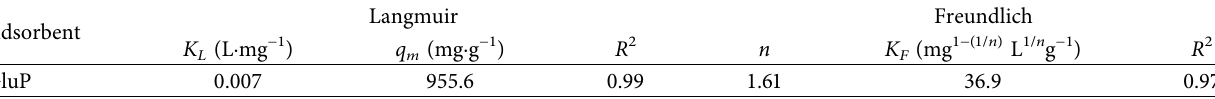
Table 3: Langmuir and Freundlich isotherm fitting parameters at 298K.